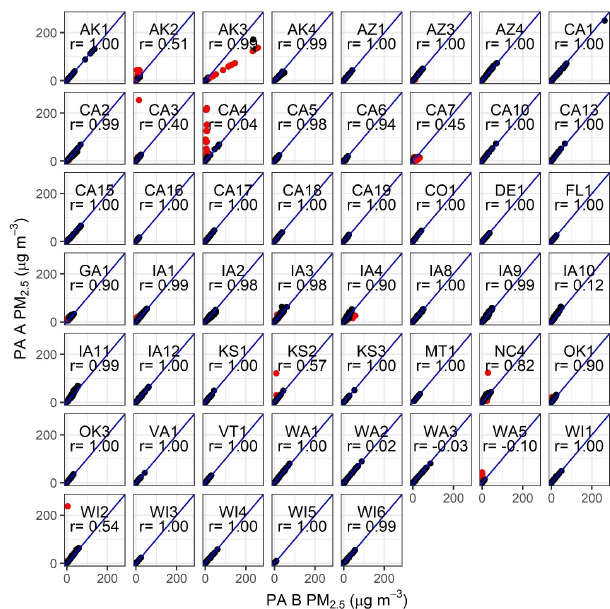
Figure 1. Comparison of 24h averaged PM 2 . 5 data from the Pur- pleAir A and B channels. Excluded data (2.1%) are shown in red and represent data points where channels differed by more than 5µgm − 3 and 61%. AK3, CA7, and WA5 were excluded from fur- ther analysis. Pearson correlation ( r ) is shown on each